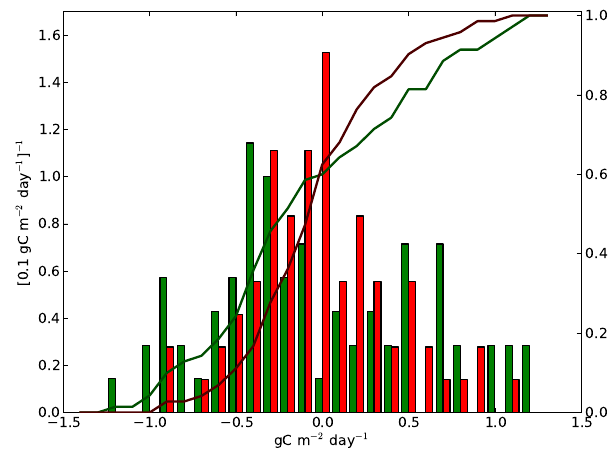
Fig. 4. Normalized distribution (bars, left axis) and cumulative distribution function (lines, right axis) of the monthly misfits in NEE ( gCm − 2 day − 1 ) between ORCHIDEE (green) or the inverted NEE (red) and the CE-L4 averages from Fig. 2.